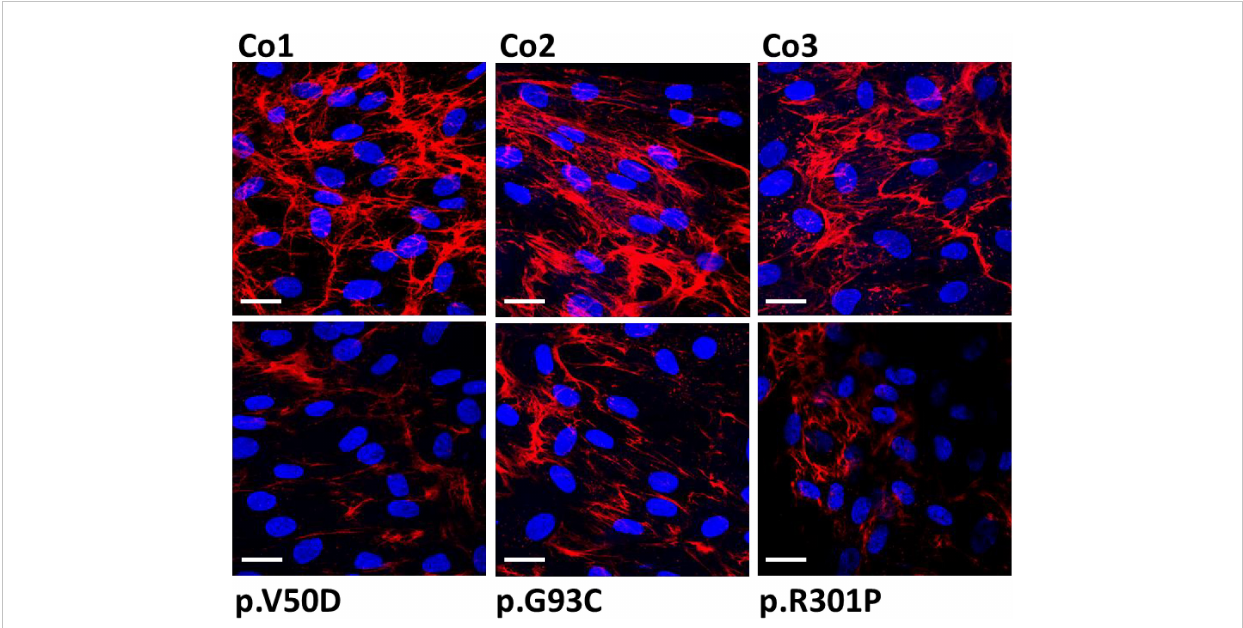
FIGURE 2 Immuno fl uorescence analysis of collagen I in control (Co) and pEDS fi broblasts. Control fi broblasts exhibit a high abundant collagen network with strong fi ber-like staining in the extracellular space. In patient fi broblasts, the quantity of the collagen network is strongly reduced and the fi ber-like staining is weaker and thinner. This is a representative fi gure of four independent experiments. Scale = 20